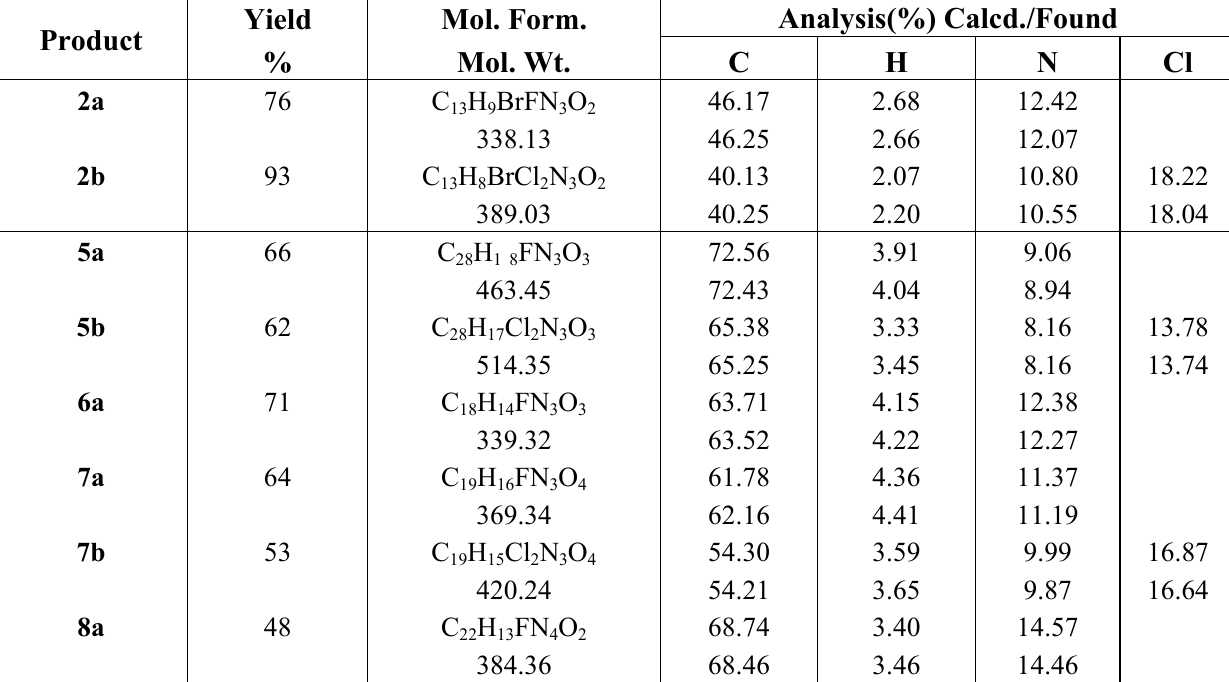
Table 2. Analytical data for the newly prepared